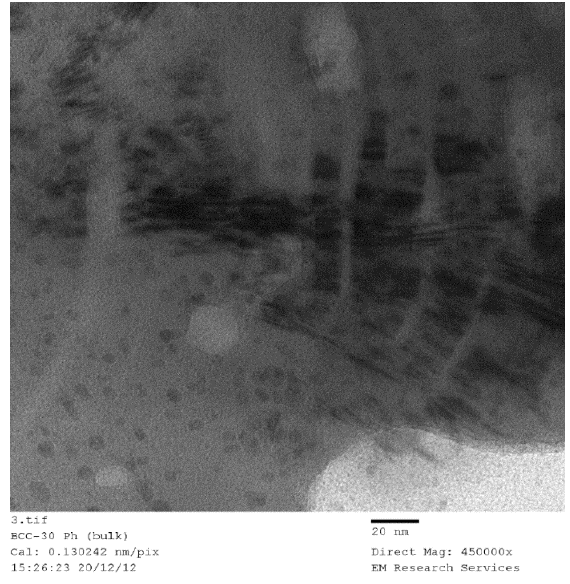
Figure 29. TEM image of the catalyst/support precursor fluid (Fe/Si = 1/4 Ph) after UV ‐ irradiation for 30 h. It shows the de ‐ aggregation of the silica particles and the formation of liquid crystal phases in the form of bar ‐ codes.